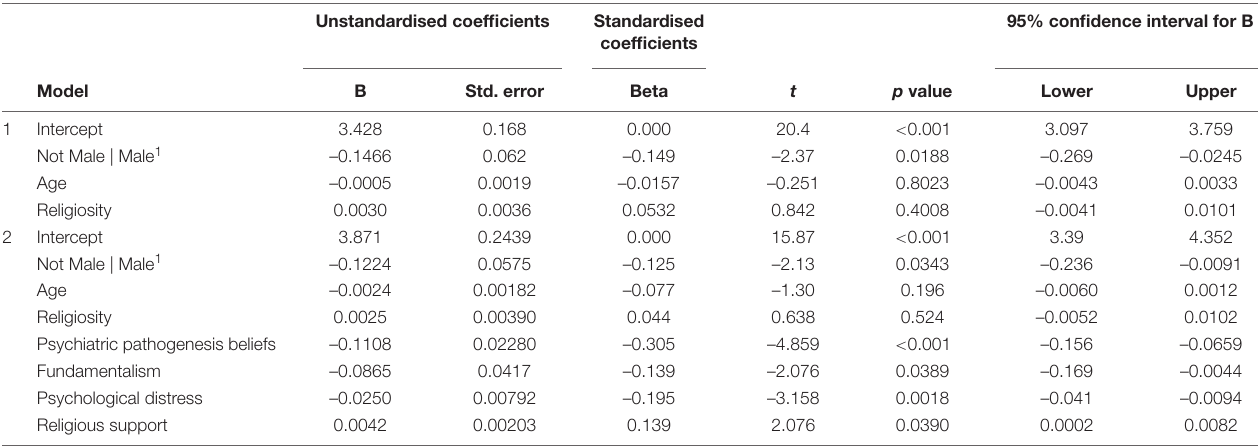
TABLE 2 | Multiple linear regression fixed effect parameter estimates using attitudes towards seeking mental health services as